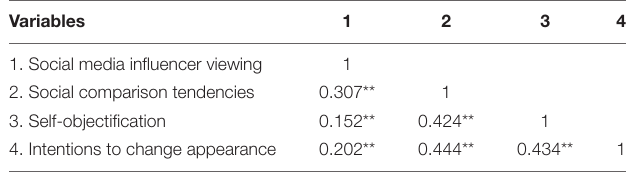
TABLE 2 | Zero-order correlations among key